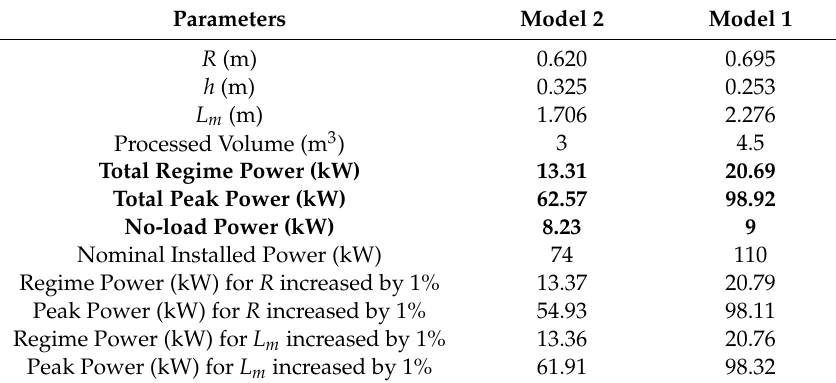
Table 4. Results of the prediction model with di ff erent geometrical